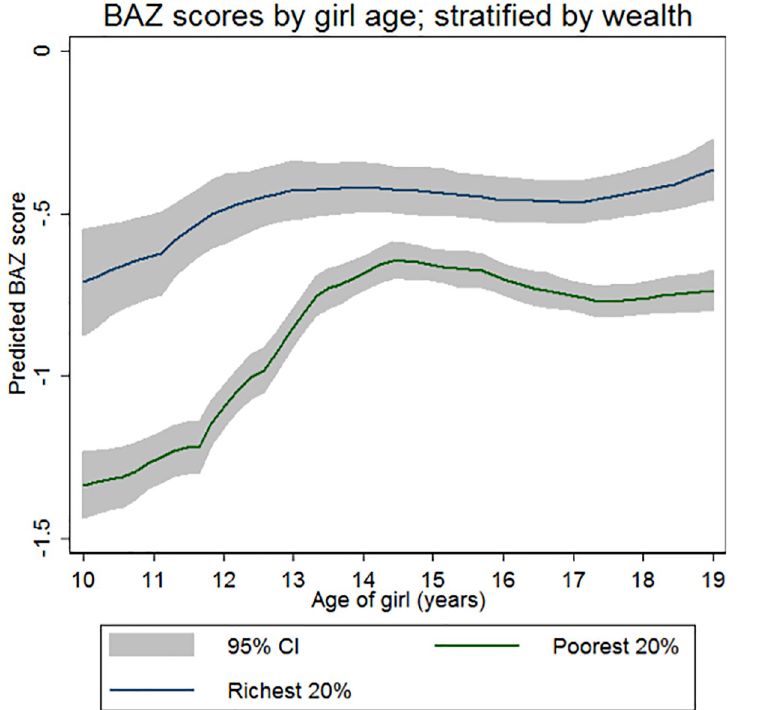
Fig 4. BAZ scores by girl age, stratified by